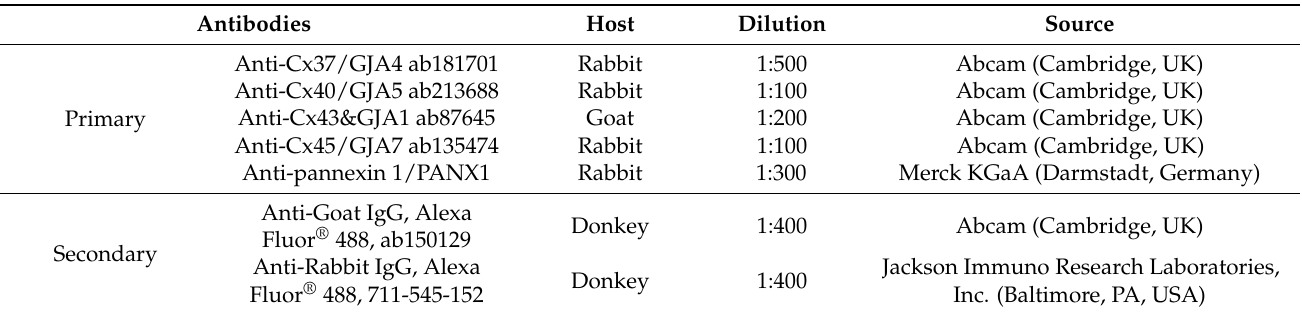
Table 1. Antibodies used for